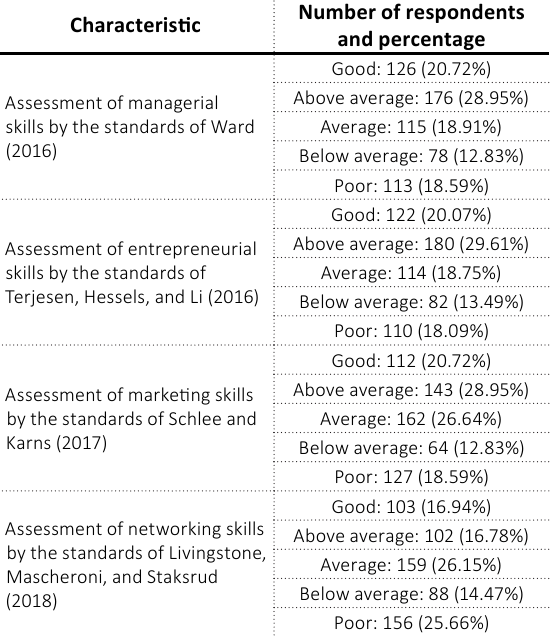
Table 3. Past experience of loan